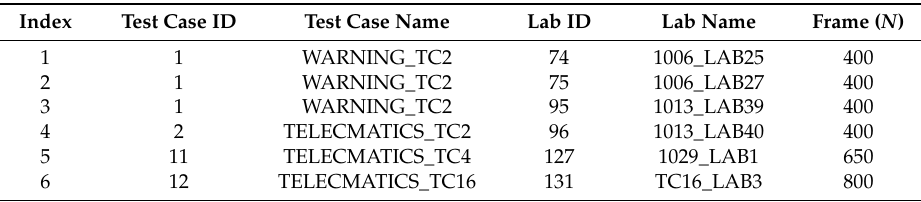
Table 1. Specification of each data set (RAM size = 29.4 KB).